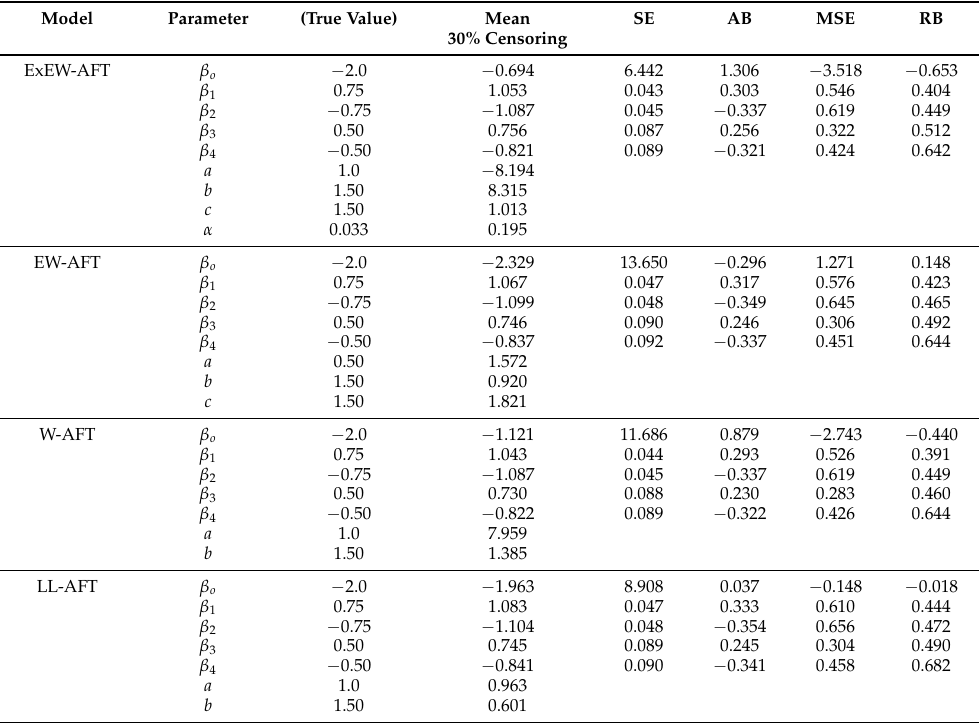
Table 3. Simulation study for scenario 1 ( n = 1000) with about 30% censored observations is used to compare model performance.